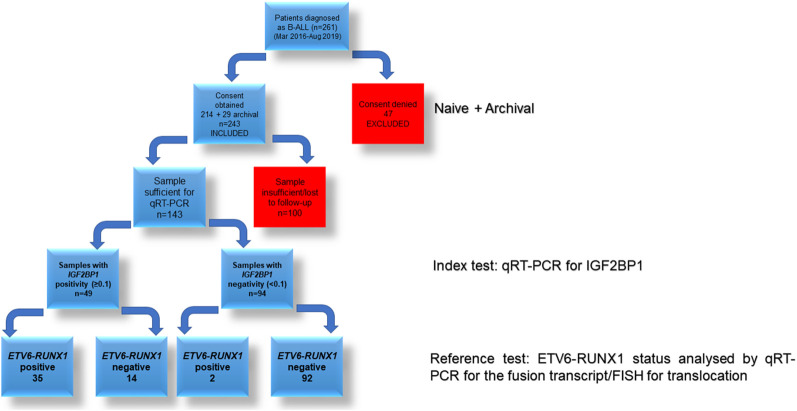
STARD diagram showing flow of participants through the study.